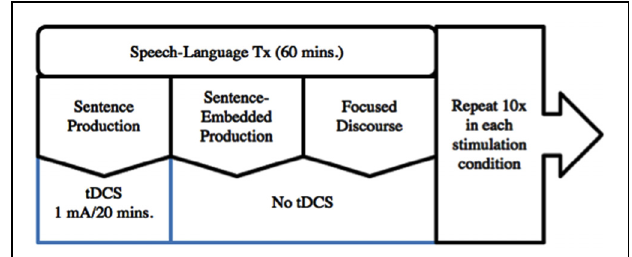
FIGURE 2 | One iteration of the experimental therapy protocol.